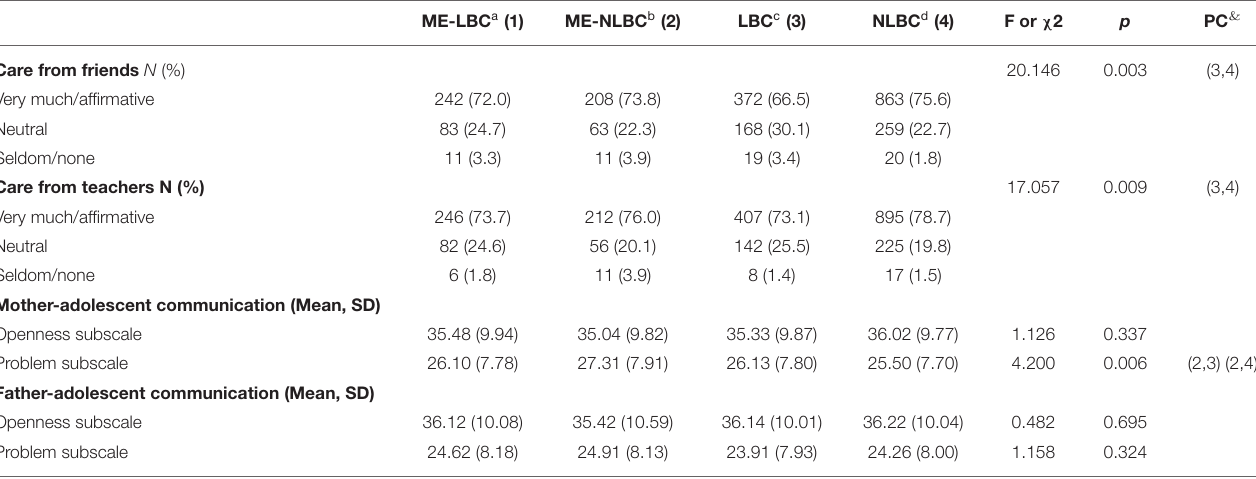
TABLE 2 | Interpersonal relationships of children stratified by